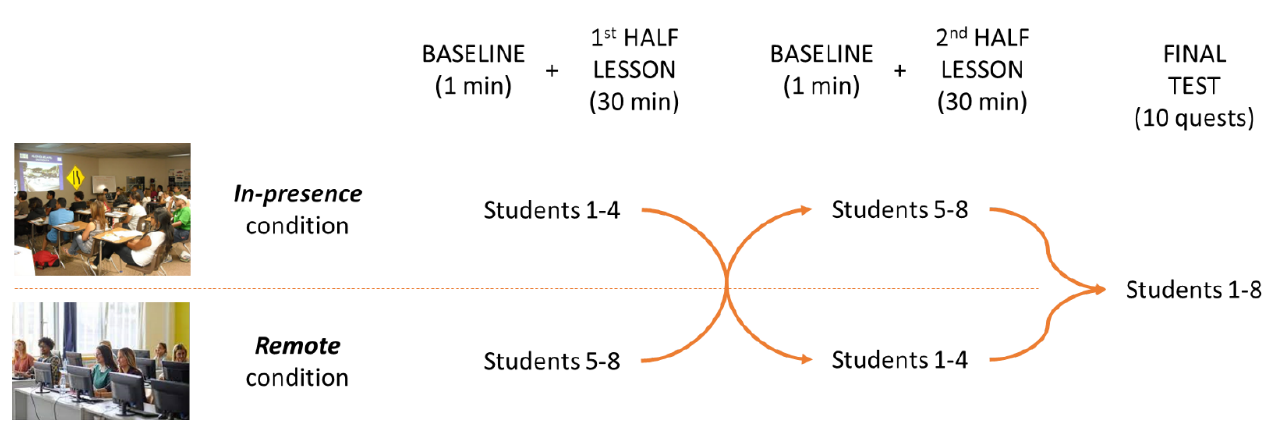
Figure 1. Overview of the experimental protocol for a subgroup of 8 participants.